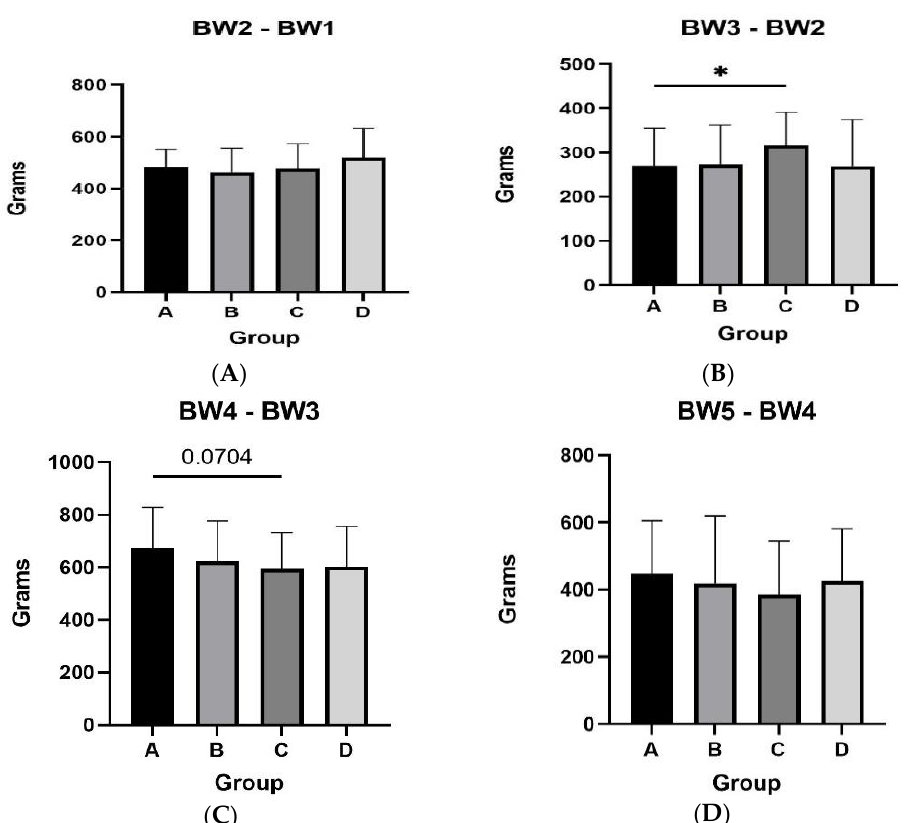
Figure 2. Body weight differences for female mink from the four experimental groups for the following intervals: at second month of the experimental period and first month (panel A ); at third month of the experimental period and second month (panel B ); at fourth month of the experimental period and third month (panel C ); at fifth month of the experimental period and fourth month ( panel D ). * p < 0.05.